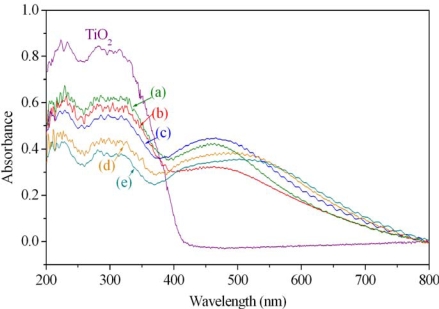
UV-Vis spectra of TiO2 and (a) 0.5, (b) 1.0, (c) 2.0, (d) 5.0, and (e) 10.0 wt% Ag in TiO2.